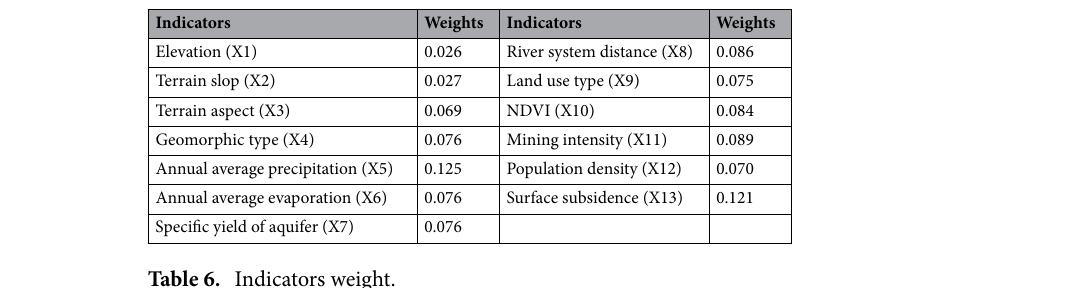
Table 6. Indicators